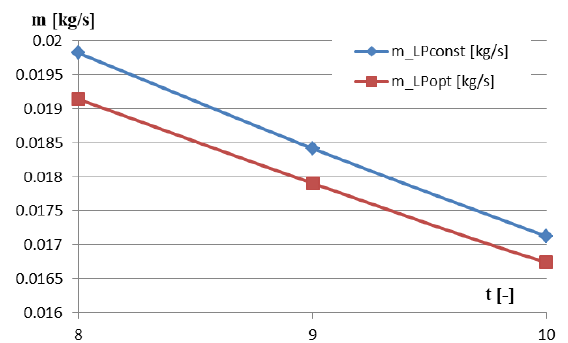
Figure 11. Mass flow obtained for the seal of equal pitch and for the designed one depending on the number of teeth t, for the clearance RC = 3.15 mm and boundary conditions 𝑝 𝑖𝑛 /𝑝 𝑜𝑢𝑡 = 2 , 𝑇 𝑖𝑛 = 300 K , 𝑝 𝑜𝑢𝑡 = 10 5 Pa .